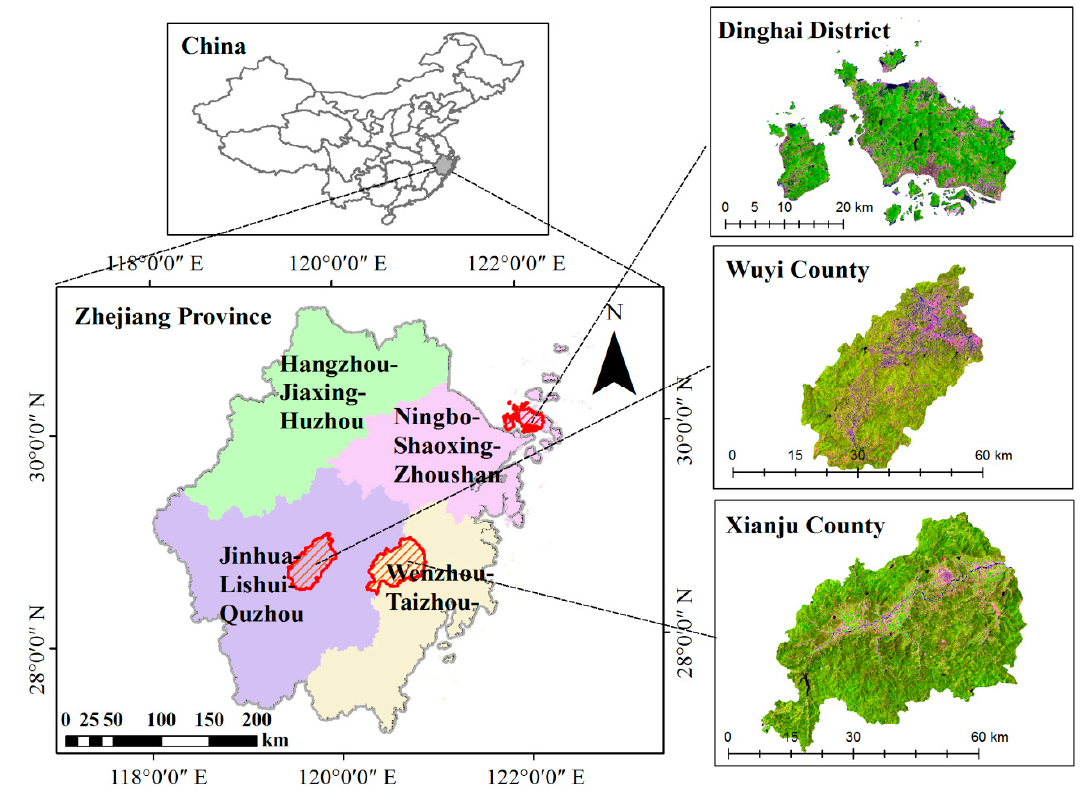
Figure 2. Locations of the study areas in Zhejiang Province, China. Table 1. Statistics of field-based aboveground biomass